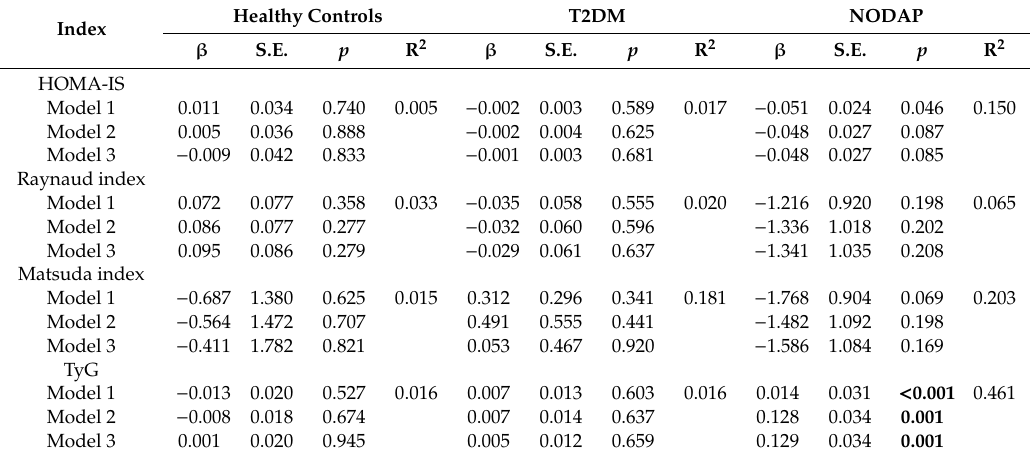
Table 3. Associations between intra-hepatic fat deposition and indices of insulin sensitivity in non-obese individuals.